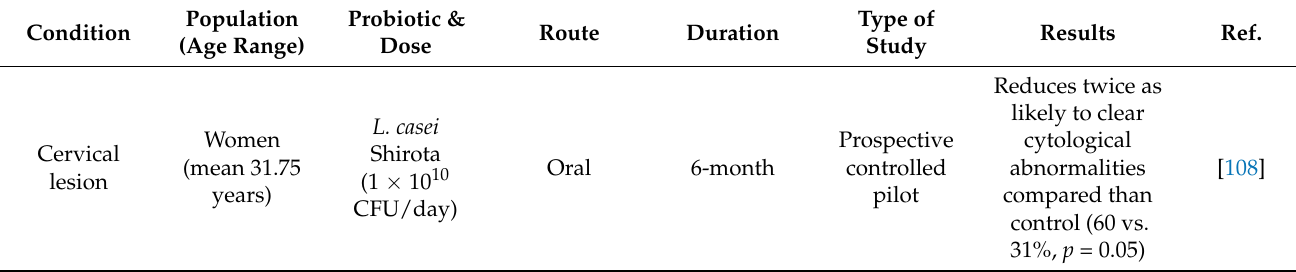
Table 4. Probiotics used in clinical trials in HPV infection, hepatic encephalopathy (HE) and Herpes Simplex-2 (HVS-2)